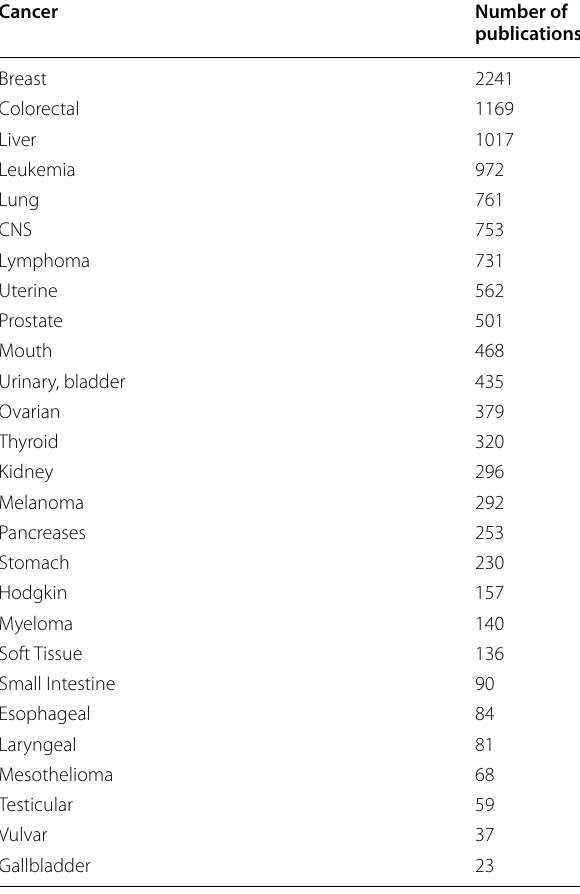
Table 4 Number of total publications per cancer type in the Arab world